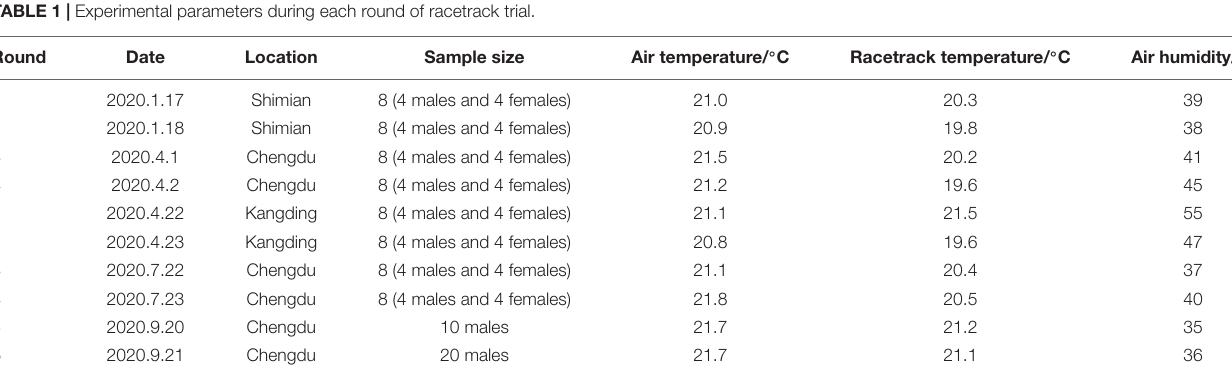
FIGURE 1 | Experimental protocols. (A) Sampling sites and common garden site. (B) Experimental schedule. (C) Setup of racetrack trial. TABLE 1 | Experimental parameters during each round of racetrack